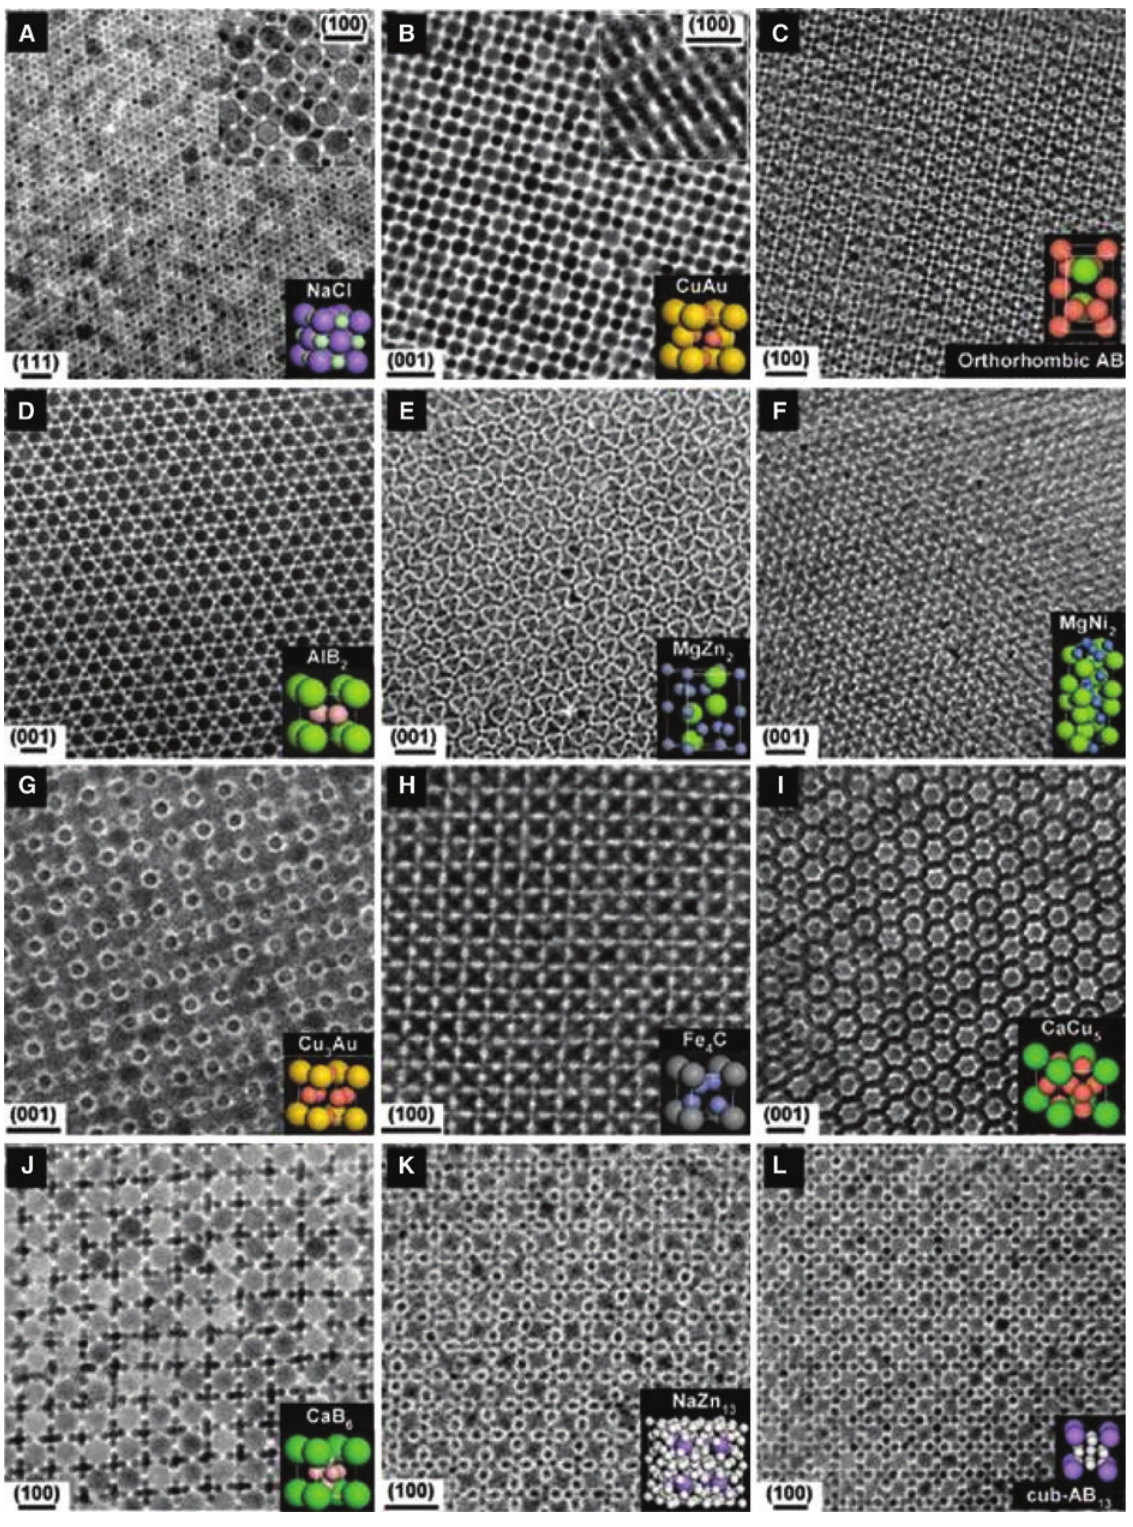
Figure 8: Lattice patterns formed by evaporating solutions of different mixtures of plasmonic and semiconductor nanoparticles. (A) 13.4 nm Fe O and 5.0 nm AuNPs. (B) 7.6 nm PbSe and 5.0 nm AuNP. (C) 6.2 nm PbSe and 3.0 nm PdNP. (D) 6.7 nm PbS and 3.0 nm PdNP. 2 3 (E) 6.2 nm PbSe and 3.0 nm PdNP. (F) 5.8 nm PbSe and 3.0 nm PdNP. (G) 7.2 nm PbSe and 4.2 nm AgNP. (H) 6.2 nm PbSe and 3.0 nm PdNP. (I) 7.2 nm PbSe and 5.0 nm AuNP. (J) 5.8 nm PbSe and 3.0 nm PdNP. (K) 7.2 nm PbSe and 4.2 nm AgNP. (L) 6.2 nm PbSe and 3.0 nm PdNP. Reprinted with permission from Ref. [84]. Copyright 2006 Springer